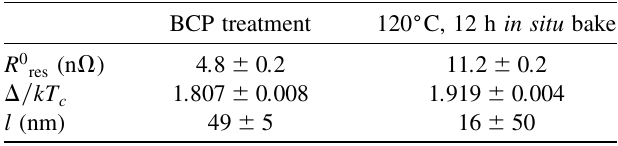
TABLE III. Weighted average values of R 0 obtained from fits of R treatment and in situ baking at 120 (cid:3) C for 12